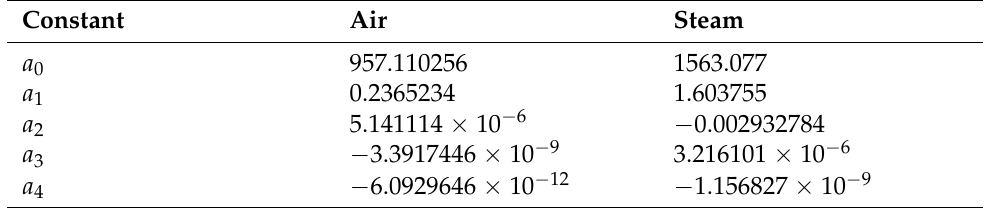
Table 6. Constants for polynomial specific heat capacity